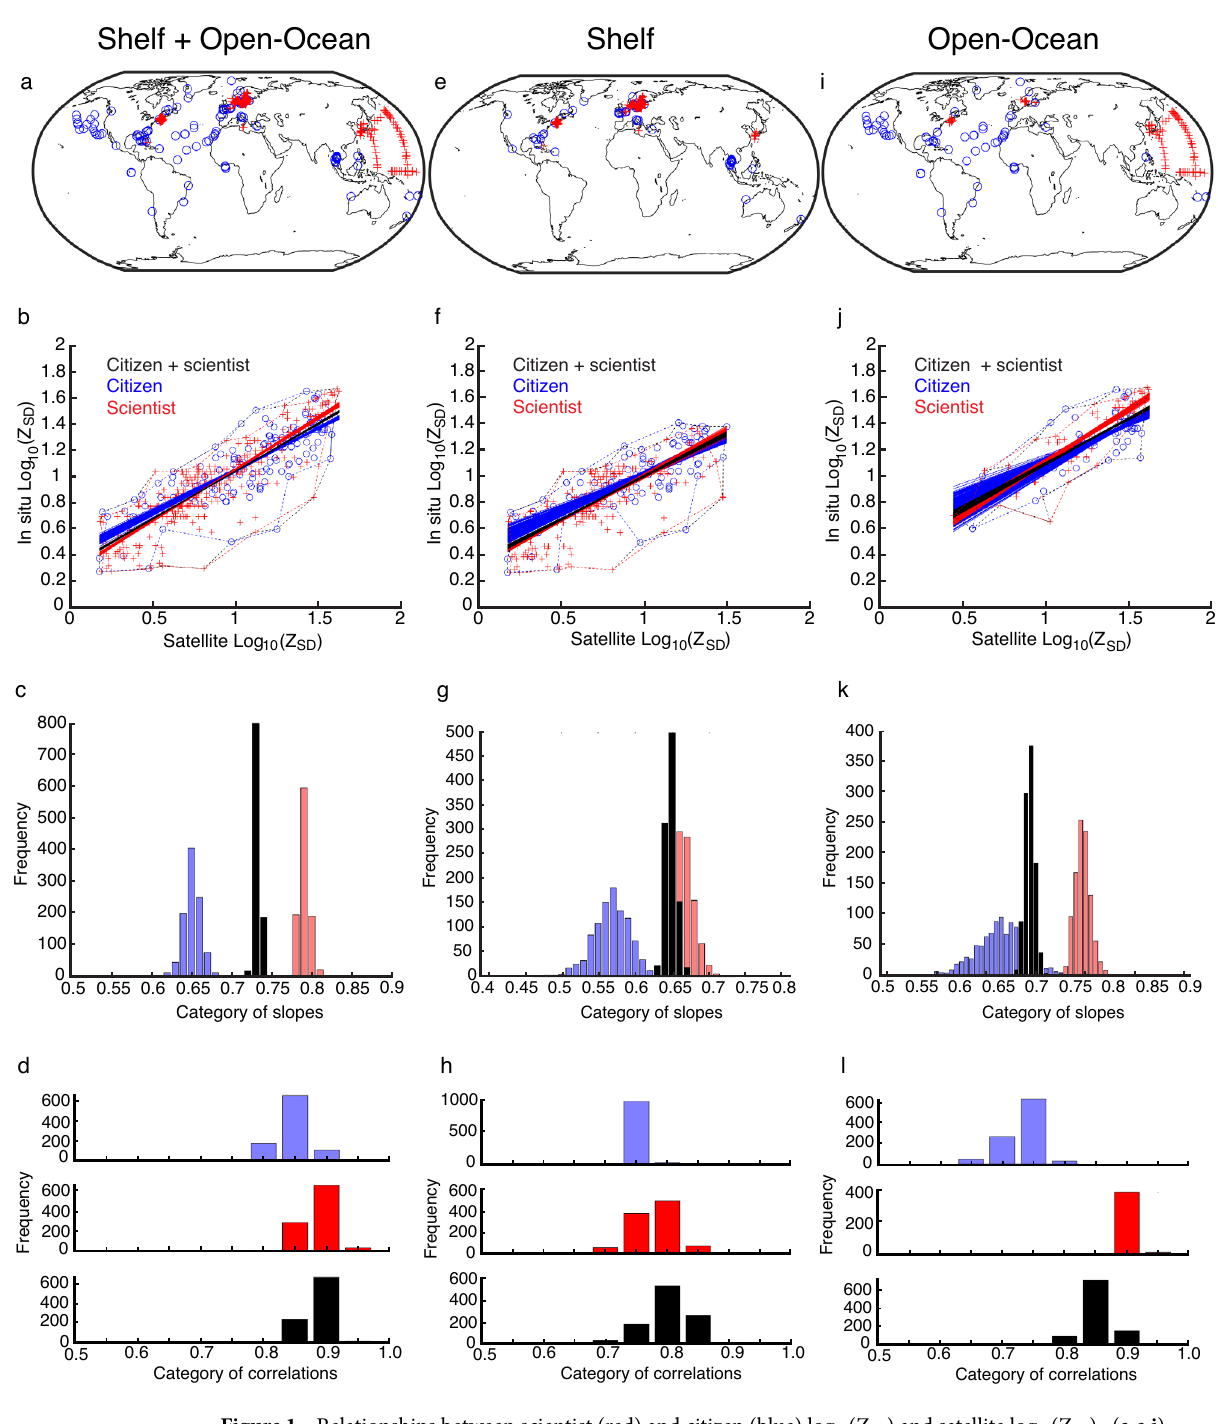
Figure 1. Relationships between scientist (red) and citizen (blue) log 10 (Z SD ) and satellite log 10 (Z SD ). ( a,e,i ) Maps showing the positions of the scientist and citizen Z SD data for shelf + open-ocean, shelf, and open- ocean, respectively. Maps were created using MATLAB version 2021a, https:// www. mathw orks. com/ produ cts/ matlab. html. ( b,f,j ) Scatterplots, polygons and regression lines showing the relationship between scientist, citizen, and satellite log 10 (Z SD ) for shelf + open-ocean, shelf, and open-ocean data, respectively. Red and blue polygons delineate the scientist and citizen data, respectively, and regression lines in black represent combined scientist and citizen data. ( c,g,k ) Histograms of regression coefficients between scientist, citizen and scientist/ citizen (black) and satellite log 10 (Z SD ) data for shelf + open-ocean, shelf, and open-ocean, respectively. ( d,h,l ) Histograms of linear correlations between scientist, citizen, combined scientist and citizen (black), and satellite log 10 (Z SD ) for shelf + open-ocean, shelf, and open-ocean data,